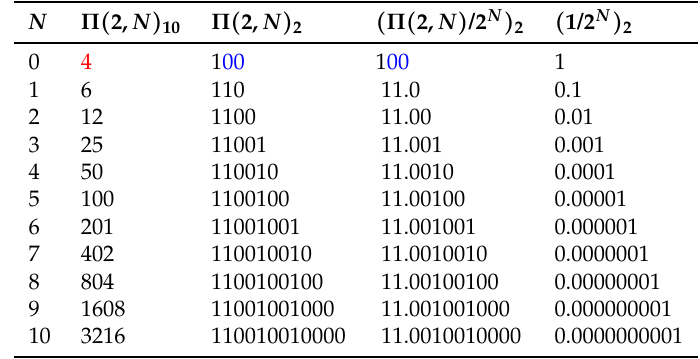
Table 2. Number of collisions Π given by Equation (13) for the binary base, b = 2. The first column reports the value of mantissa N . The second column is the resulting number of collisions in the decimal base. The third column is the number of collisions written in the binary representation. The fourth column is the binary representation of the number π with N digits in the fractional part. The fifth column gives the systematic error according to Equation (55). The case where approximation (14) fails as compared to (13) is highlighted by red. The blue digits are not correctly predicted by the Galperin billiard. N Π ( 2, N ) 10 Π ( 2, N ) 2 ( Π ( 2, N ) /2 N ) 2 ( 1/2 N ) 2 100 100